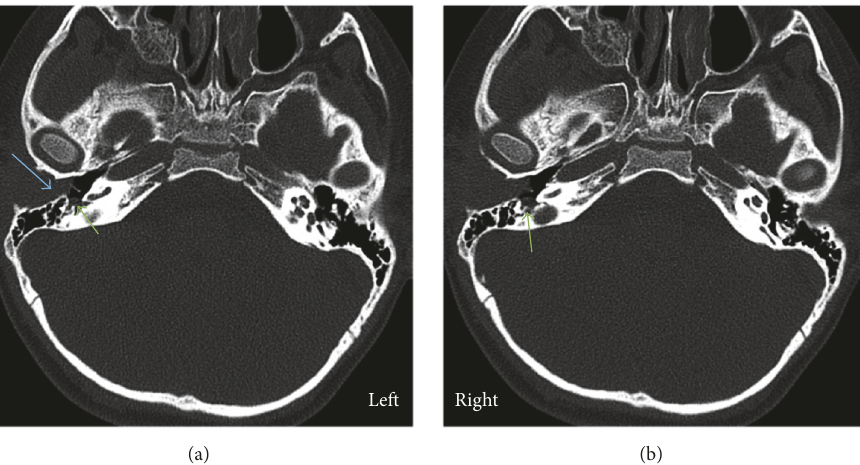
Figure 1: Axial CT scan. Showing soft tissue mass in the right external auditory canal with widening and occlusion of right ear canal (blue arrow) and small middle ear soft tissue opacity (green arrow).